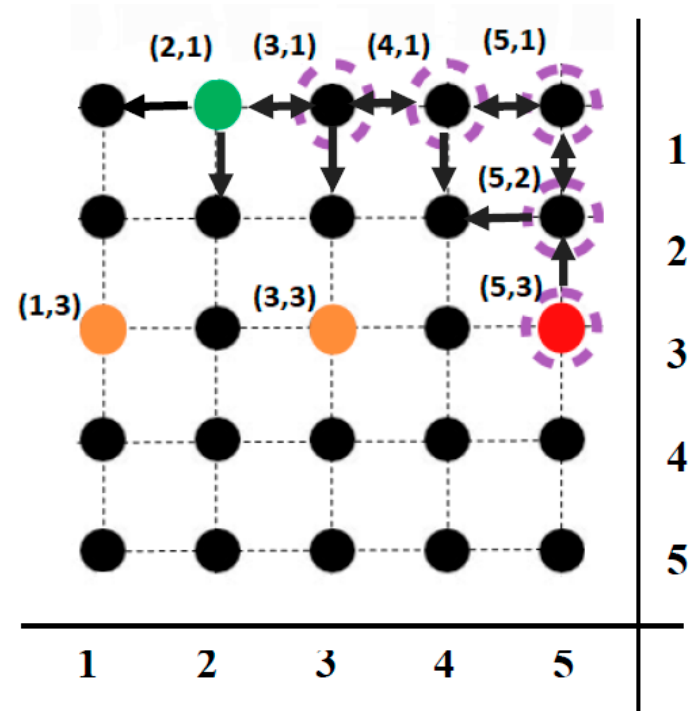
Figure 22. The heuristic function results for collision avoidance of the A 3 microparts from the static A 1 , A 2 microparts.